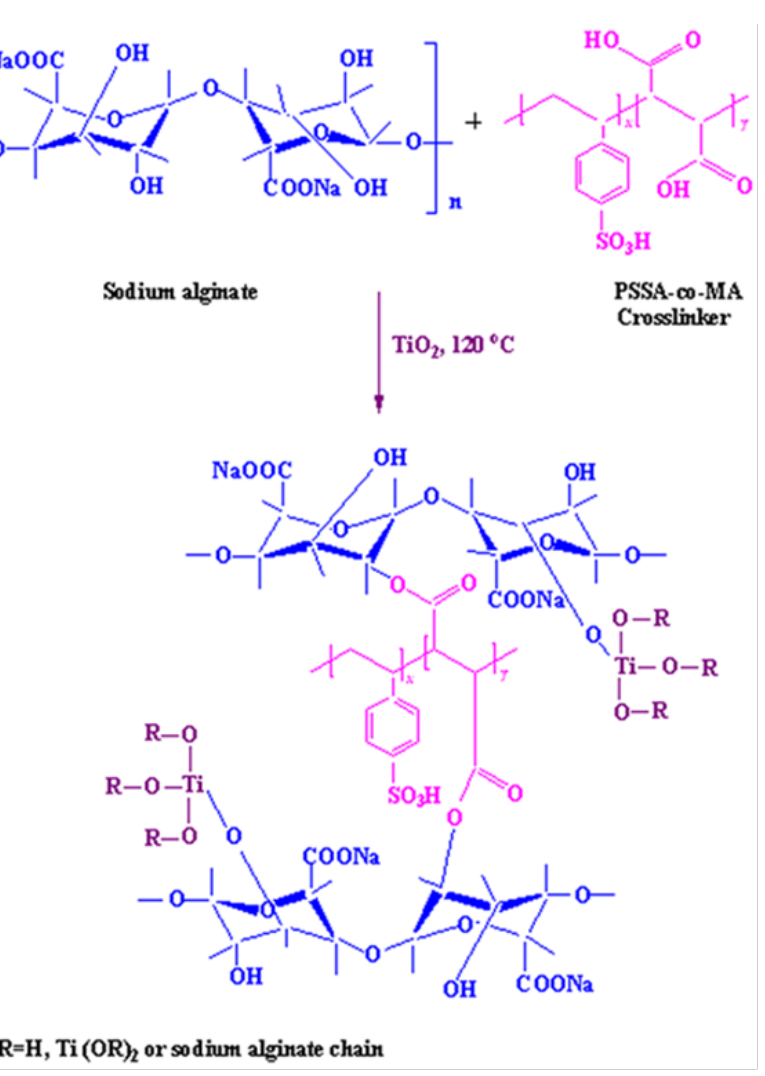
Figure 9. Scheme for the preparation and structural representation of TiO 2 -incorporated crosslinked sodium alginate membranes.